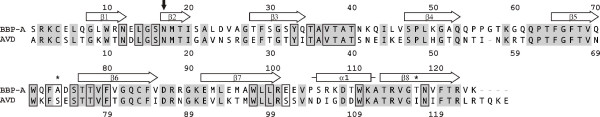
Sequence alignment of BBP-A and AVD. Identical residues are shown in gray shading. The signal peptides are omitted from the alignment. Secondary structure elements are indicated according to the BBP-A – BSO structure (chain A). The amino acids within 4 Å of BSO in the BBP-A – BSO structure (and the equivalent residues in AVD) are boxed. The residues mutated in this study are indicated by an asterisk. The glycosylation site of BBP-A is indicated by an arrow.